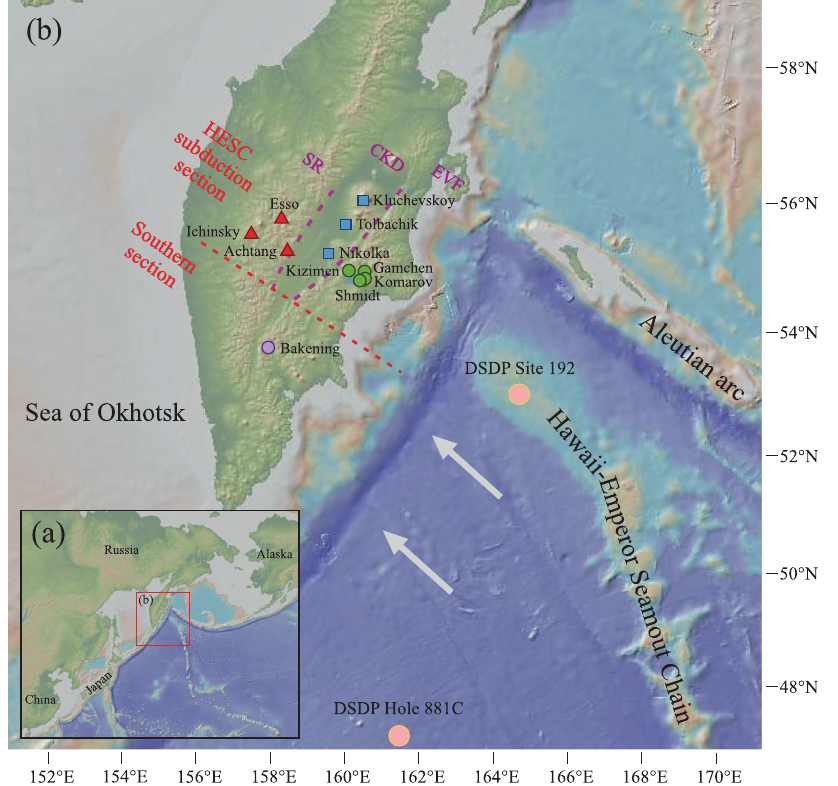
Fig. 1 | Location of Kamchatka subduction zone. a Location of Kamchatka arc and surrounding areas. b Map of the Kamchatka arc and Hawaii-Emperor Sea- mount Chain (HESC). Solid circle, square and triangle indicate the sampled vol- canoes from Eastern Volcanic Front (EVF), Central Kamchatka Depression (CKD) and SredinnyRidge (SR), respectively. Also shown is the locationoftwo drillcores from which samples were analyzed in this study to constrain the sediment and